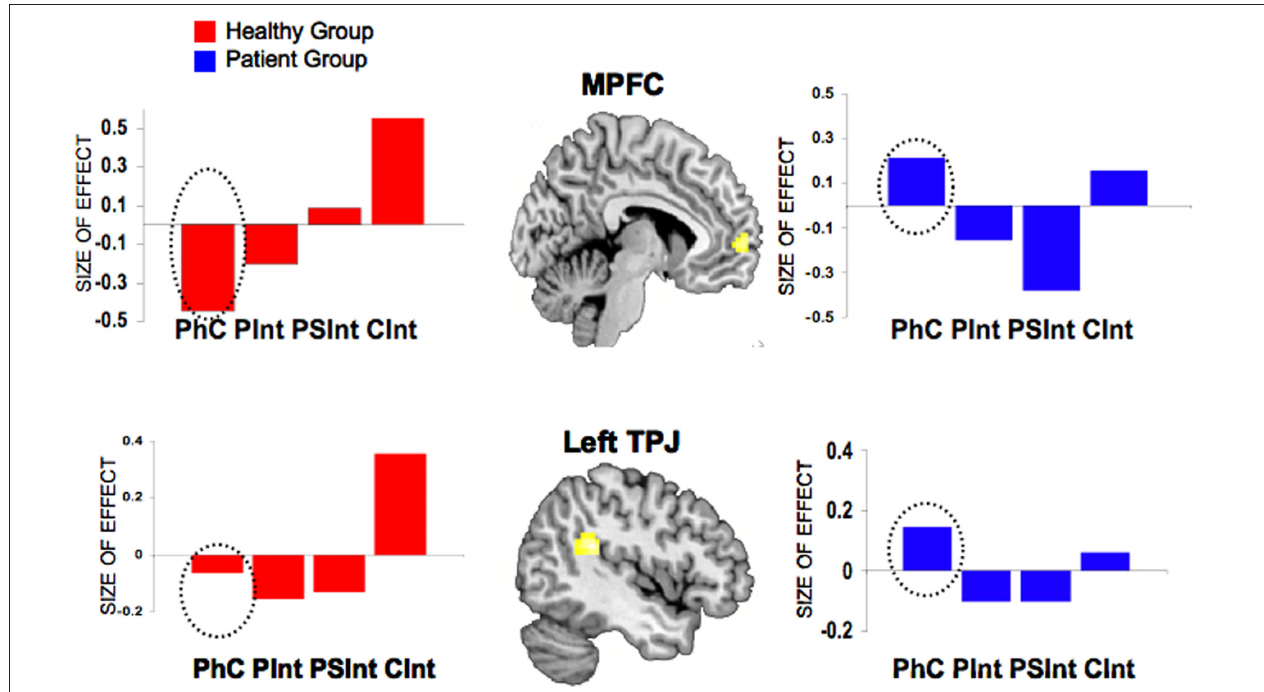
FIguRe 8 | group comparisons between healthy controls and patients with paranoid schizophrenia. Mean activation effects (estimated beta parameters, 95% confidence interval) of the contrast CInt vs Ph-C for MPFC and left TPJ. The activation effects were extracted from the second level between-group ANOVA. Dashed circles indicate the beta parameters for the control condition (Ph-C). Ph-C, Physical causality; CInt, Communicative